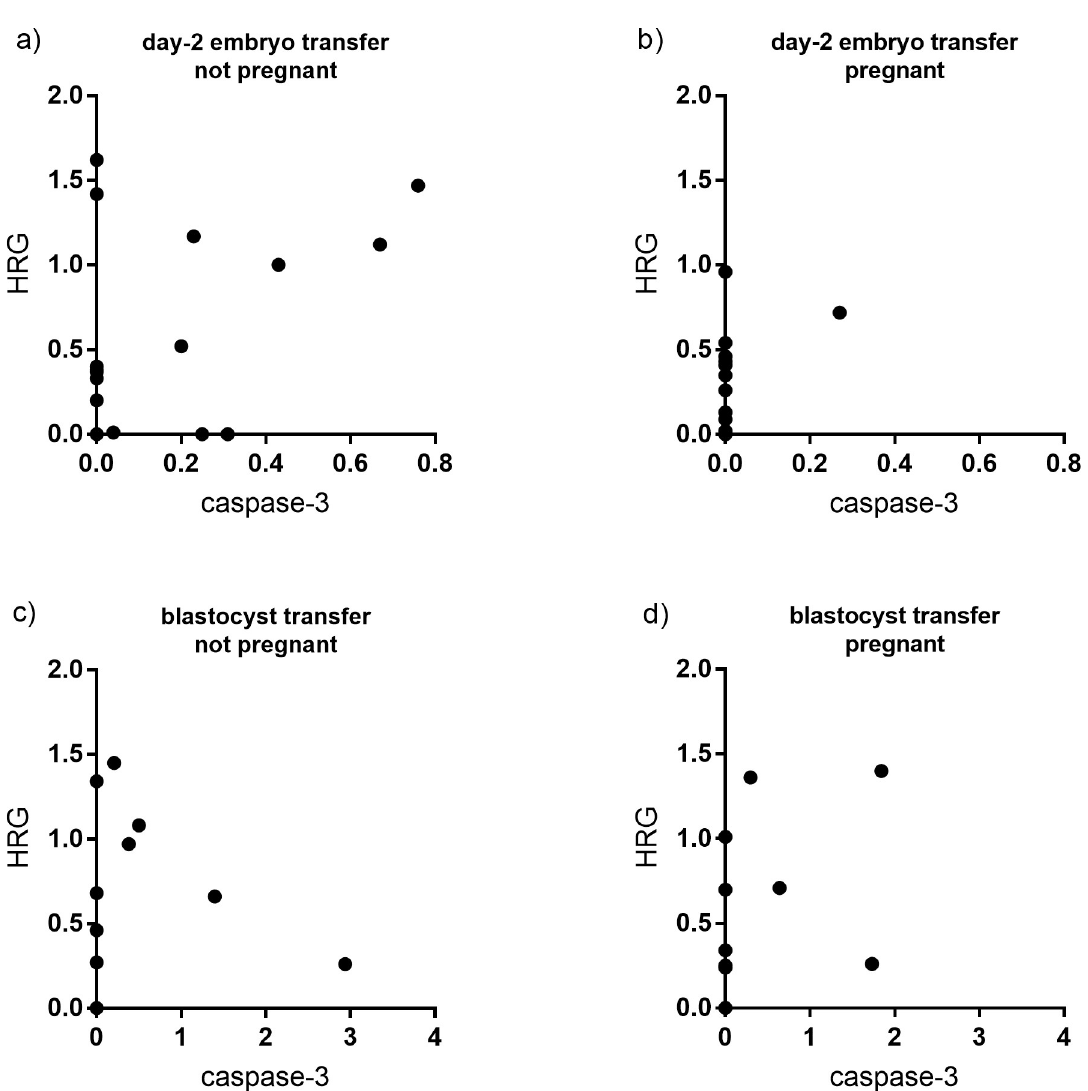
Fig 4. Caspase-3 and HRG levels in secretomes from embryos resulting and not resulting in a pregnancy. The scatter plot shows the relative levels of caspase-3 and HRG in culture media from each transferred day-2 cultured embryo and high-quality blastocyst resulting in and not resulting in a pregnancy. a) Day-2 cultured embryos not resulting in a pregnancy. b) Day-2 cultured embryos resulting in a pregnancy. c) High-quality blastocysts not resulting in a pregnancy. d) High-quality blastocysts resulting in a